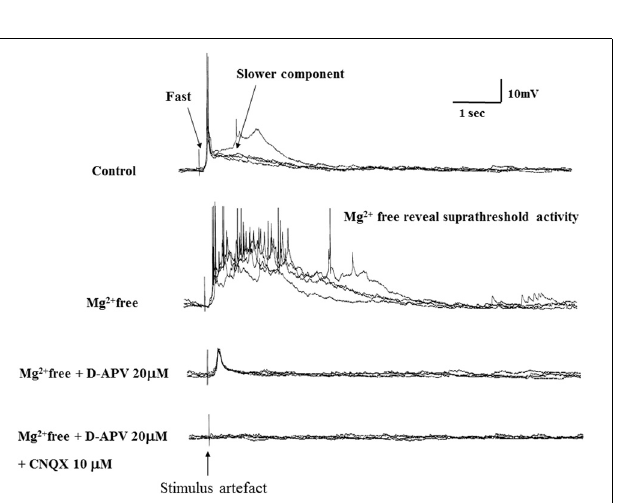
FIGURE 4 | Evoked EPSPs in a POA neuron under different recording conditions. After achieving whole cell access, recordings were made in current-clamp mode. Typically, neurons were perfused sequentially with normal ACSF, Mg 2 + free ACSF, 20 μ M AP-5 (in Mg 2 + free ACSF) and 10 μ M CNQX (in Mg 2 + free ACSF) for 10min each before recordings.